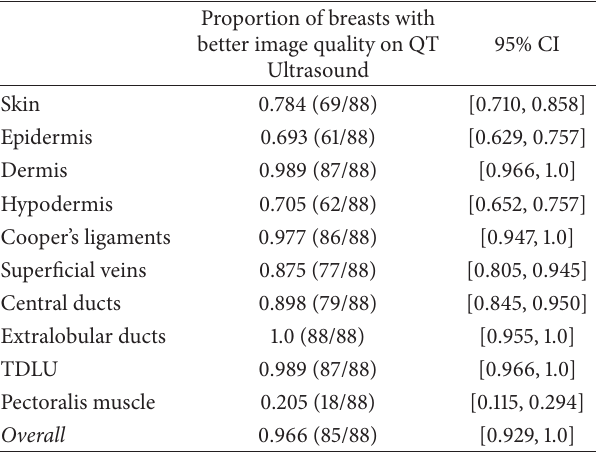
Figure 8: A craniocaudal (axial) view of the transmission (speed of sound) image as shown here in a woman with a dense breast. The relationship between the ducts and the TDLU can be better appreciated in this view.